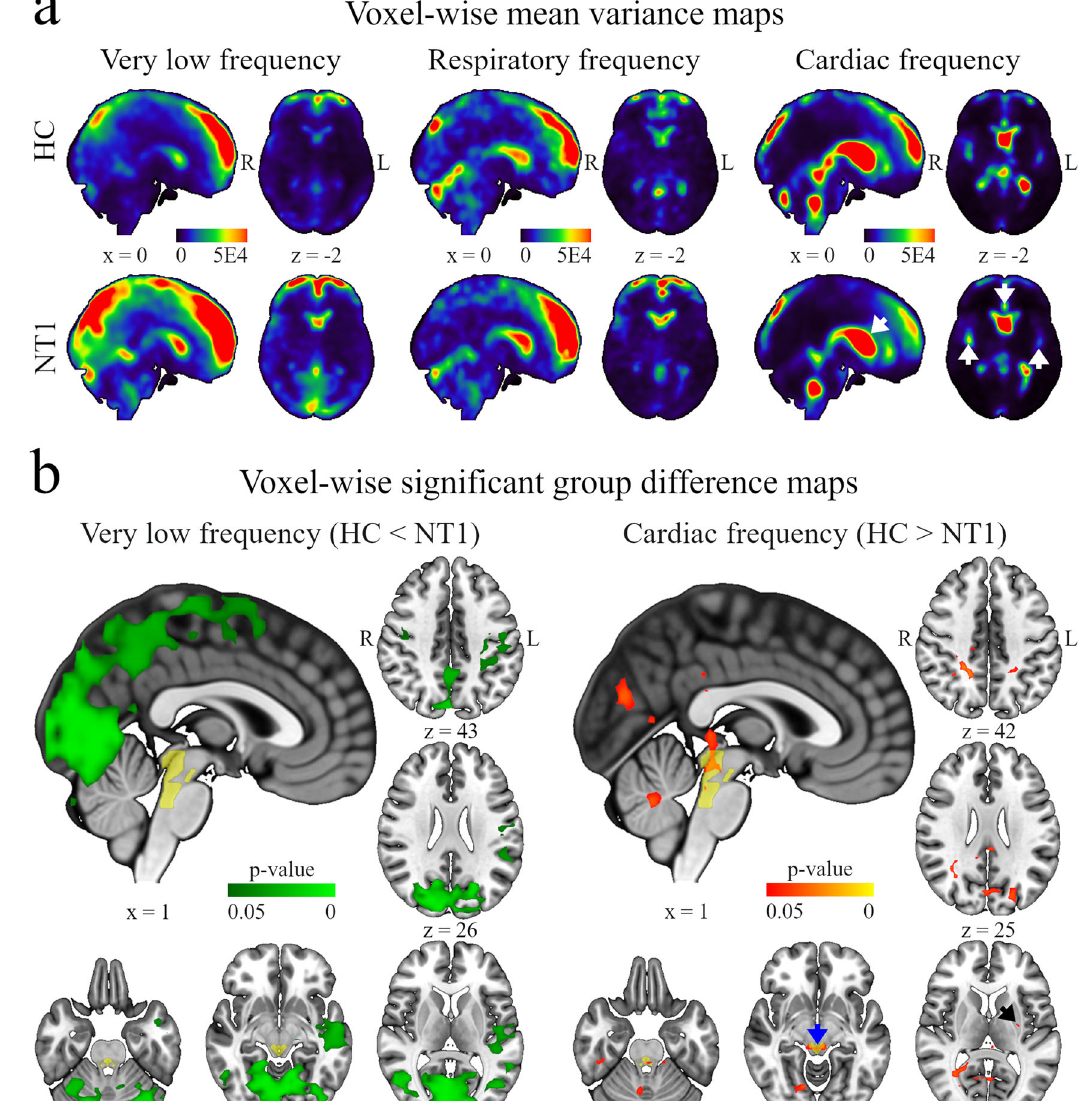
Fig. 2 Frequency-wise variance results. a Voxel-wise mean-variance maps. Very low frequency- and respiratory-related variances mostly populate anterior and posterior cortical regions, while cardiac-related variance dominates in the ventricular system and large arteries. White arrows = anterior-, middle cerebral arteries, and ventricular system. Color bars represent a sliding scale of mean-variance values across all healthycontrols (HC) and patients with narcolepsytype 1 (NT1), respectively. R right, L left, x displayed sagittal plane, z displayed axial plane. b Voxel-wise signi fi cant group difference maps. Very low-frequency results locate (HC< NT1, green area) mostly intheposterior brain areas,while cardiac-related results (HC> NT1, red area)interestingly overlap with ascending arousal network (AAN). Black arrow = ;left basal ganglia, blue arrow = aqueductus sylvii, yellow area = AAN. P values < 0.05 are signi fi cant, n = 22 HC vs. 22